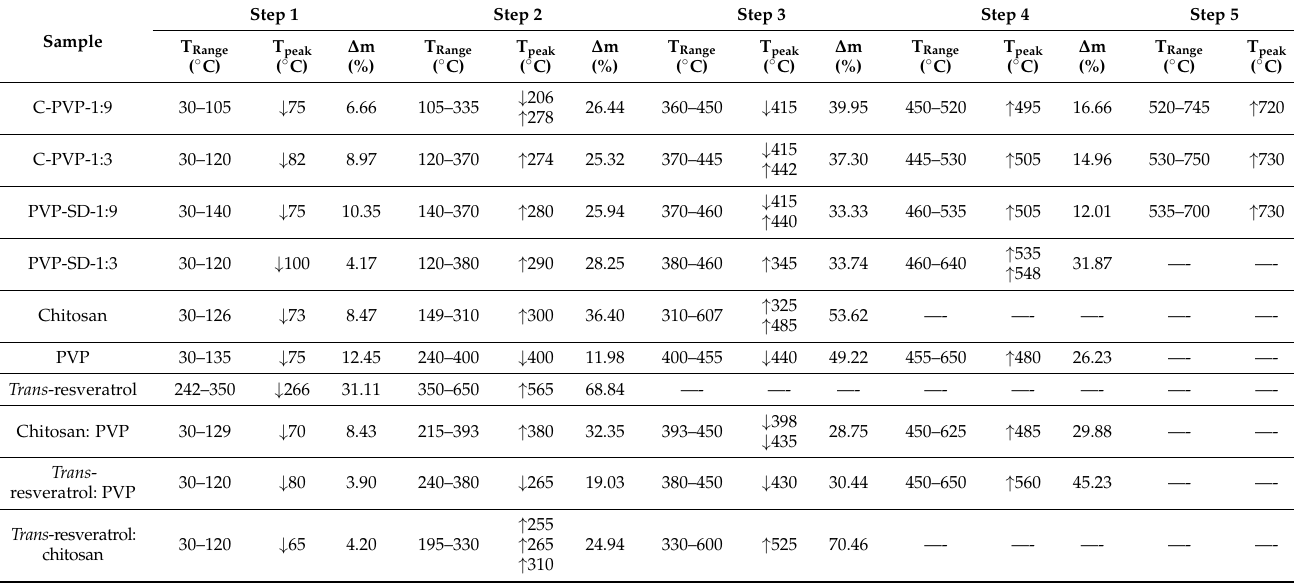
Table 4. Thermal data from the TG-DSC